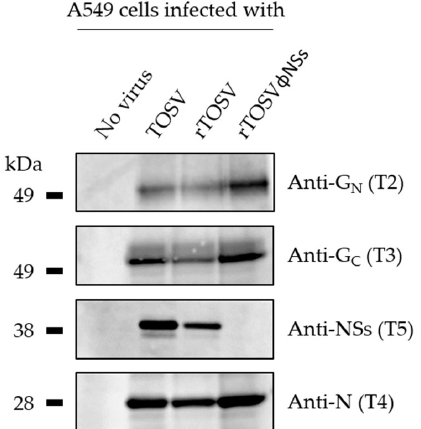
Table 1. List of polyclonal antibodies generated in this study.